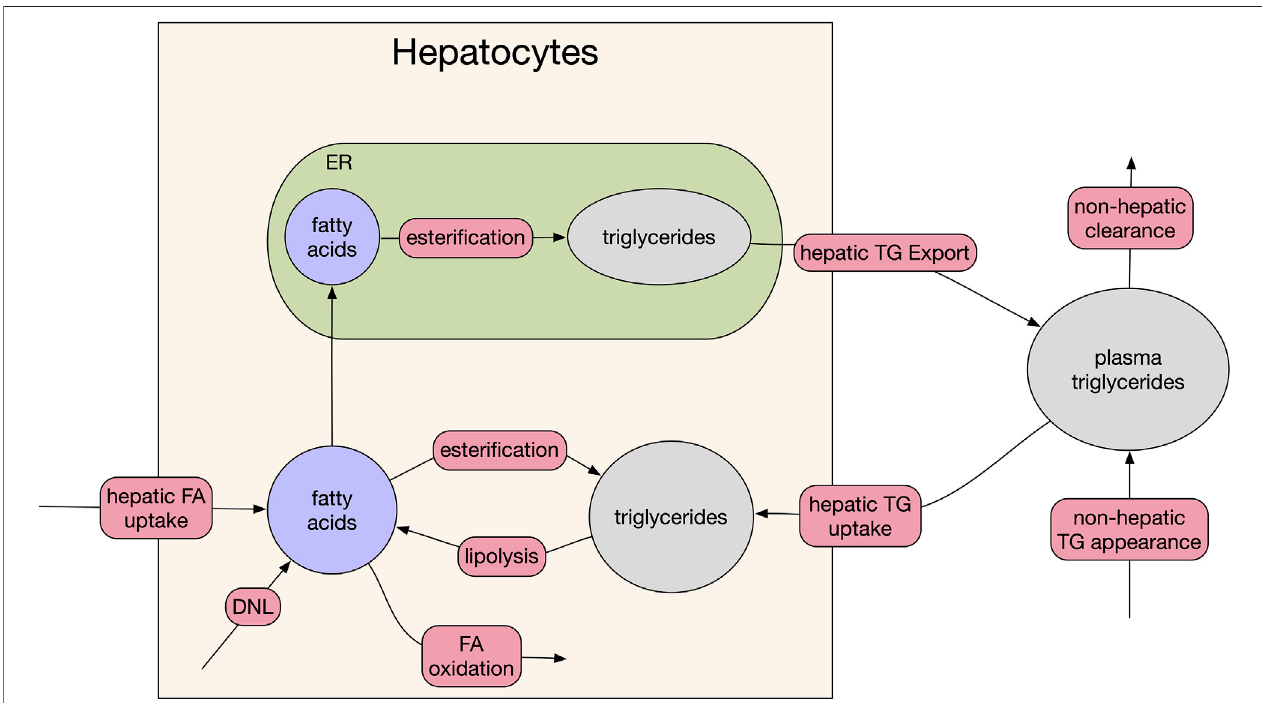
FIGURE1| Modelschematic.Thethreecompartmentsofthemodelare:plasma,hepatocytecytosol,andhepatocyteendoplasmicreticulum(ER).Redbubbleson arrows represent fl uxes ofthe model, fi lled ellipses are the fi ve species of themodel. Forclarity, feedback betweenDNL and fatty acid(beta)oxidationand cytosolic fatty acid levels and FA uptake are omitted (see source code for full